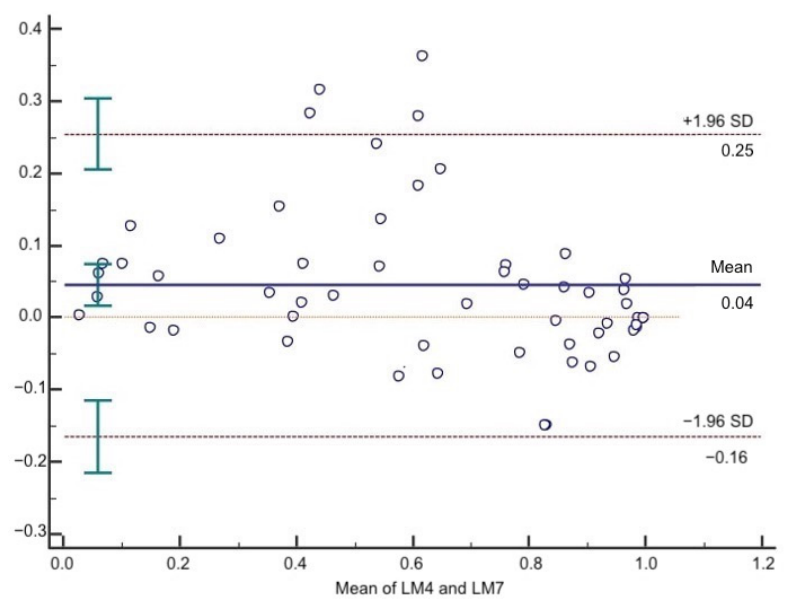
Figure 2. Bland–Altman plot of LM4 and LM7. The solid line represents the mean of the difference. The dashed lines define the LOA. The 95% upper and lower LOA were 0.25 and − 0.16, respectively.